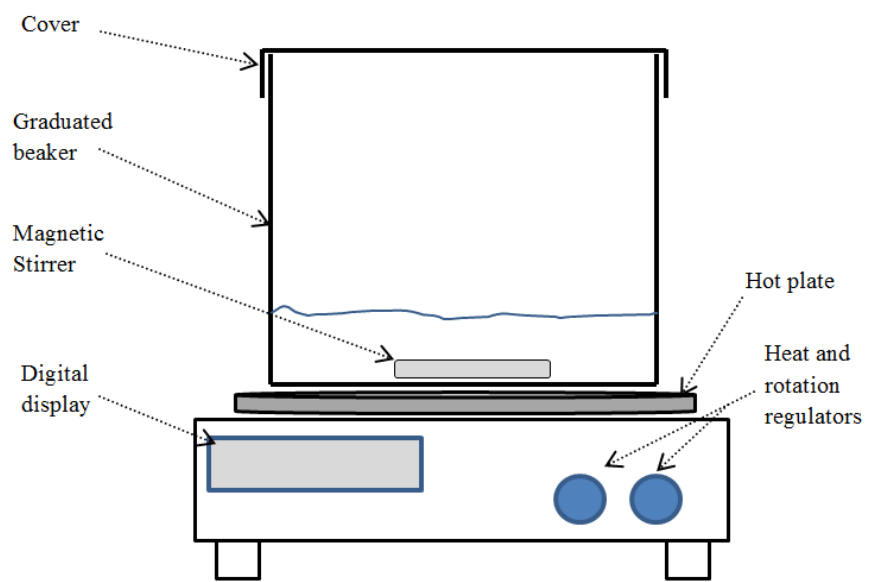
Figure 1. Schematic diagram of the test